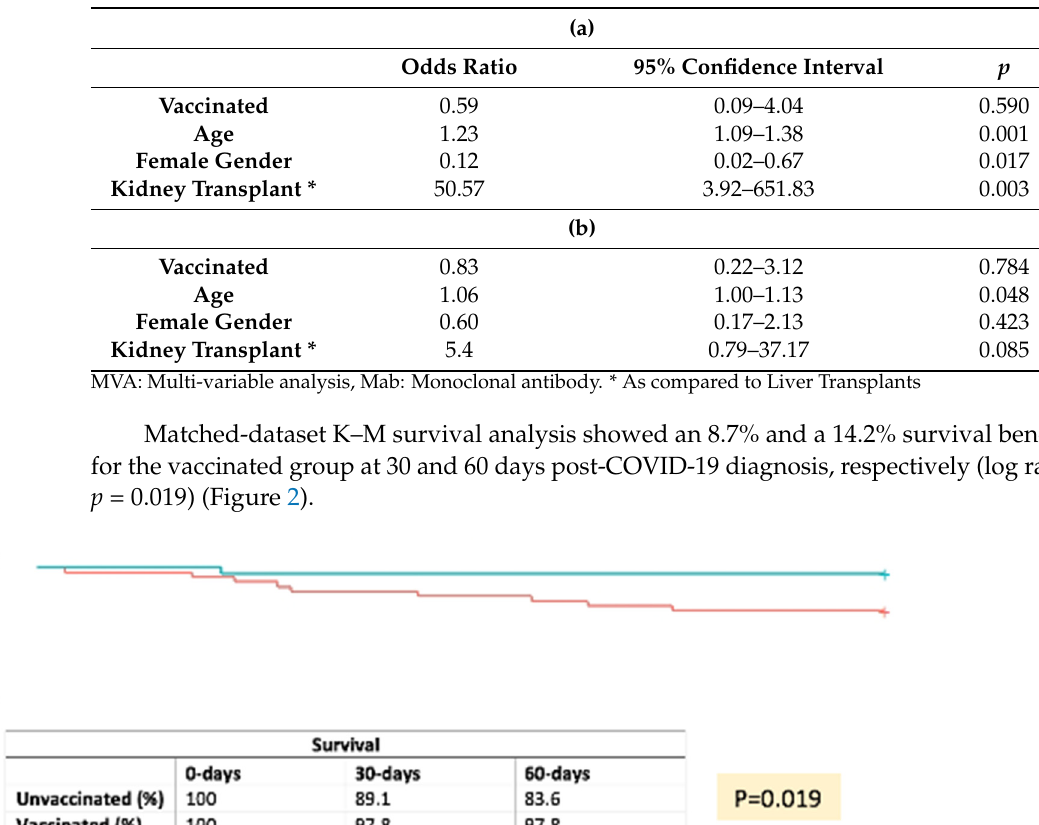
Table 3. Mab Sensitivity MVA for 60-day mortality (N = 64). (a) Mab Sensitivity Reduced MVA for 60-day Mortality (b) Mab Sensitivity Reduced MVA for Hospitalization.